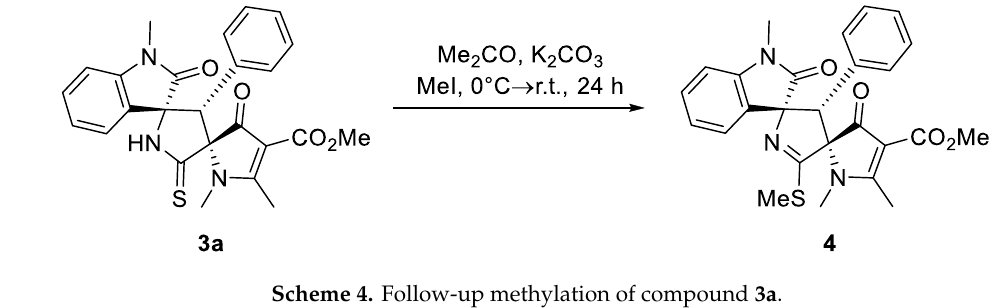
7 of 14 Figure 3. Single crystal X-ray structure depicting product 3b . Thermal ellipsoids are shown at 50% probability. The follow-up methylation of compound 3a with iodomethane in the presence of K 2 CO 3 in acetone gave the S -methylated product 4 (Scheme